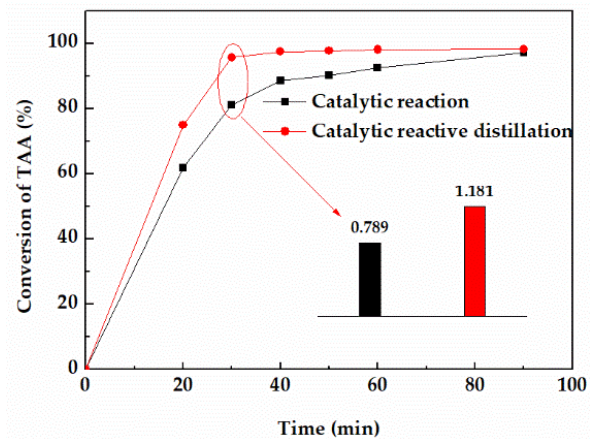
Figure 5. Effect of distillation on the conversion of TAA.